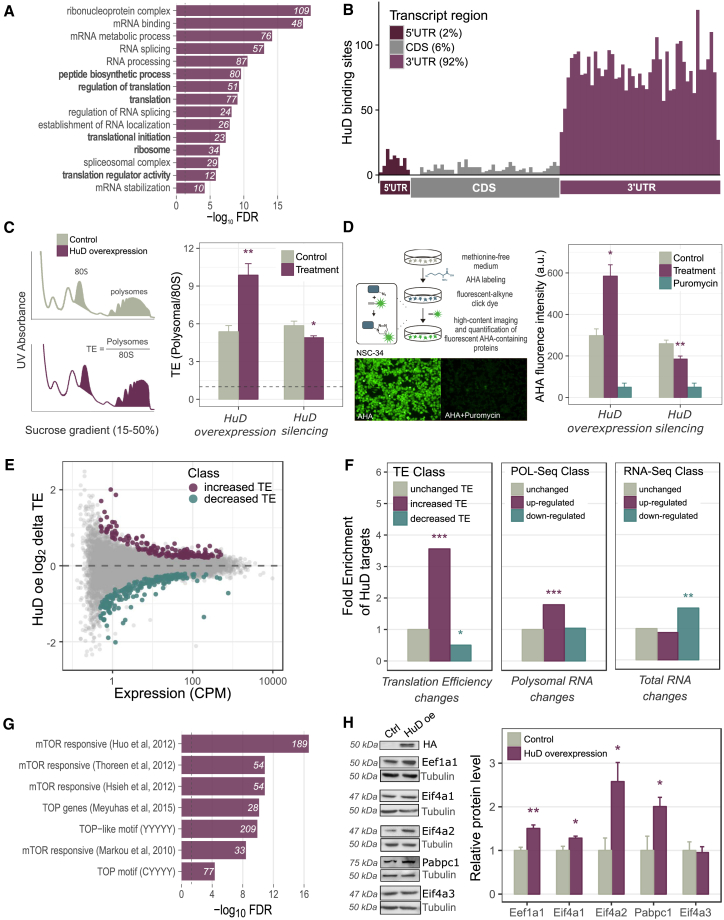
HuD Increases Global and Target-Specific Translation(A) Top enriched Gene Ontology terms among HuD mRNA targets are related to RNA processes, including splicing, transport, stability, and translation (highlighted in bold).(B) Metaprofile of HuD binding sites along protein coding transcripts, showing binding enrichment in 3′UTRs.(C) Right panel: representative sucrose gradient profiles in control and HuD overexpressing NSC-34 cells. Left panel: calculation of the global translation efficiency upon HuD silencing and overexpression.(D) Right: schematic representation of Click-iT AHA assay to quantify de novo protein synthesis in NSC-34 cells. Left: detection of de novo protein synthesis upon HuD silencing and overexpression. Puromycin, a translation inhibitor, was used as negative control.(E) Transcriptome-wide translation efficiency changes upon HuD overexpression in NSC-34 cells. Scatterplot displaying for each gene the average expression signal (CPM) against the log2 change in translation efficiency (delta TE) upon HuD overexpression. Genes with increased or decreased TE are highlighted.(F) Enrichment analysis of HuD RNA targets among genes with increased or decreased TE upon HuD overexpression, compared to enrichments associated with genes changing at either the polysomal or the total RNA level. Fisher’s test ∗p < 0.05, ∗∗p < 0.01, and ∗∗∗p < 0.001.(G) Enrichment of mTOR responsive mRNAs among HuD targets, as listed in multiple literature sources.(H) Western blot analysis of HuD targets (Eef1a1, Eif4a1, Eif4a2, Pabpc1) and negative control (Eif4a3) in HEK293 cells transiently transfected with HuD. Tubulin was used as reference. Experiments were performed at least in triplicate.In (C), (D), and (H), data are represented as mean ± SEM; t test ∗p < 0.05, ∗∗p < 0.01, and ∗∗∗p < 0.001.See also Figure S2.